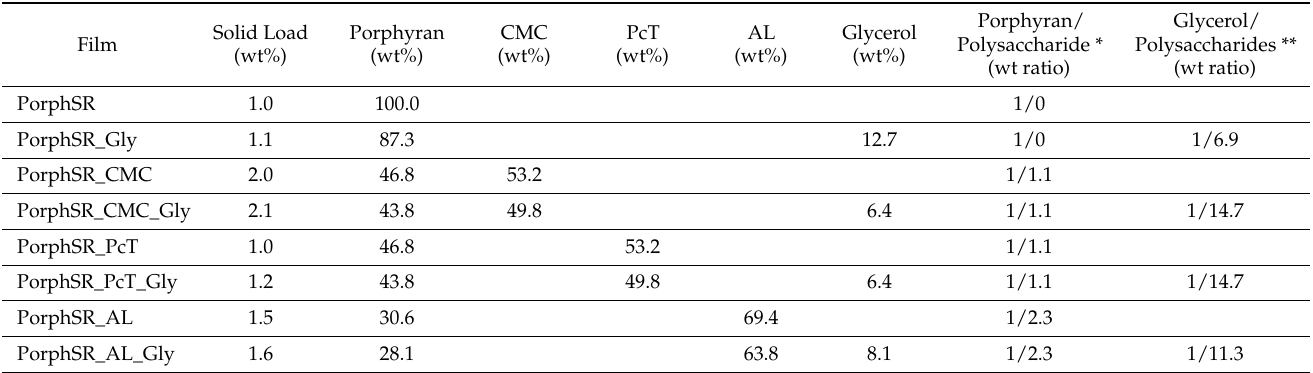
Table 2. Solid contents and compositions (based on dry weight) of the produced porphyran-based solutions, calculated from